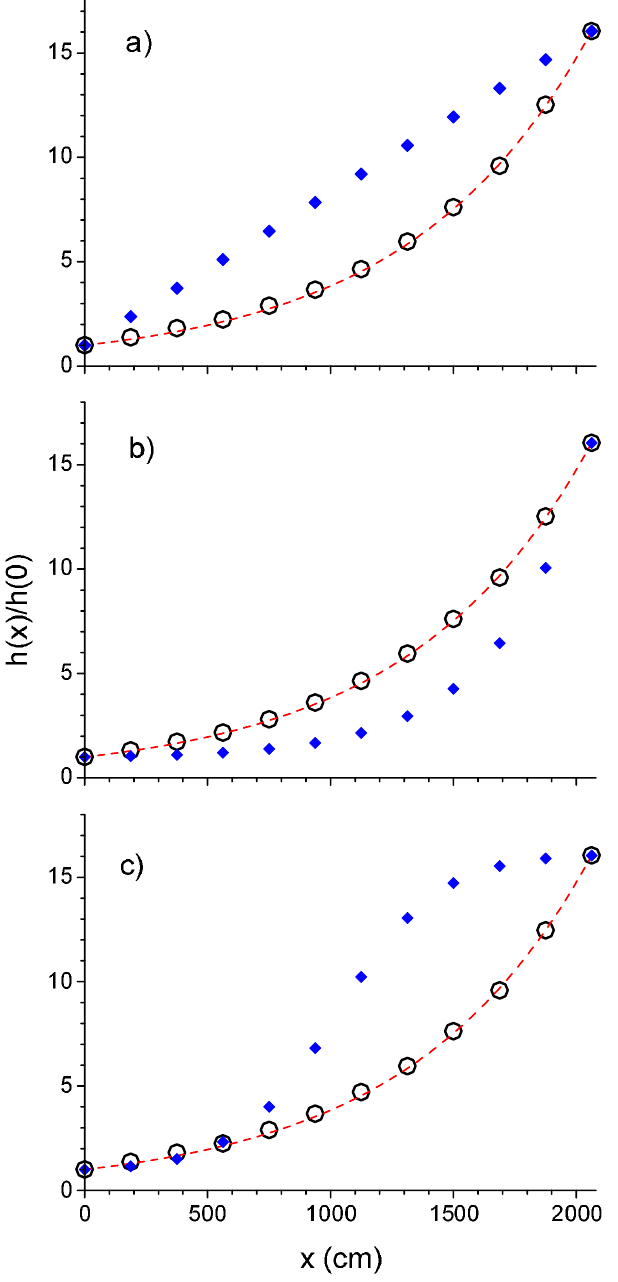
FIG. 11. (Color) Initial guess for gap optimization procedure ( (cid:1) ), final optimized values ( (cid:13) ), and the exponential curve (dashed line) are plotted. In (a), the initial guess is a m (cid:2) 0 (linear) profile; in (b), the initial guess is the m (cid:2) 2 profile; and in (c), the initial guess the profile from Eq.